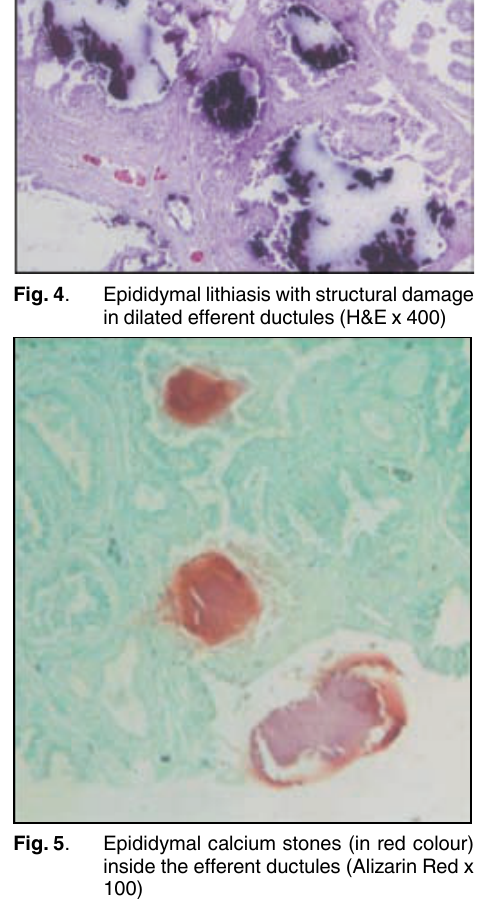
Fig. 5 . Epididymal calcium stones (in red colour) inside the efferent ductules (Alizarin Red x